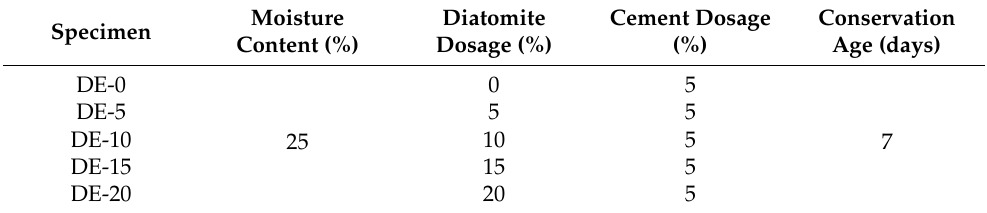
Table 5. Experimental design scheme.